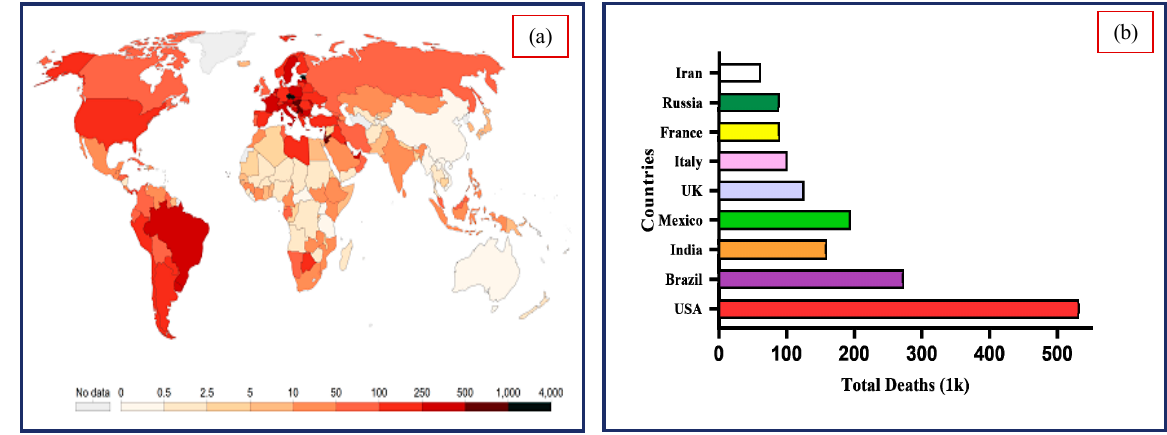
Figure 1. ( a ) Daily new confirmed COVID-19 cases Worldwide ( b ). COVID-19 death rate statistics among top ten infected countries last updated 17 March 2021 [2]. (Sources: Center for Systems Science and Engineering (C.S.S.E.) at Johns Hopkins University, Baltimore, MD, USA).